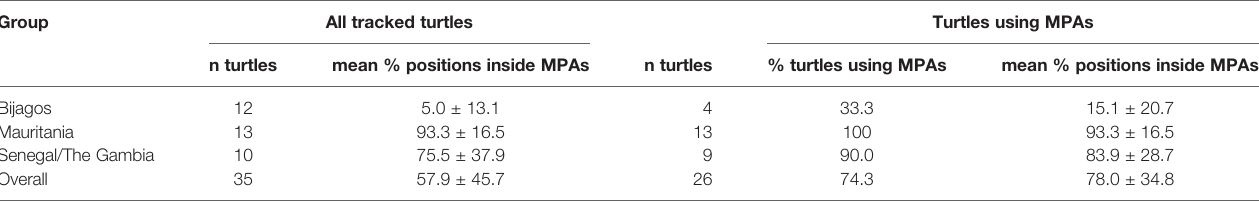
‘ Group ’ refers either to a calculation for all turtles (i.e., Overall) or subsets split by foraging destinations. Mean estimates are shown with ± standard deviation.